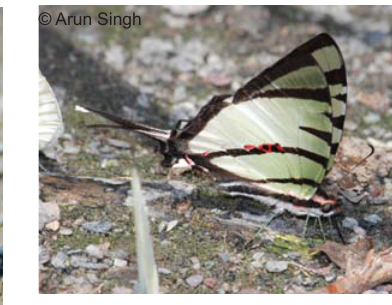
Image 12. Fourbar Swordtail Graphium agetes agetes